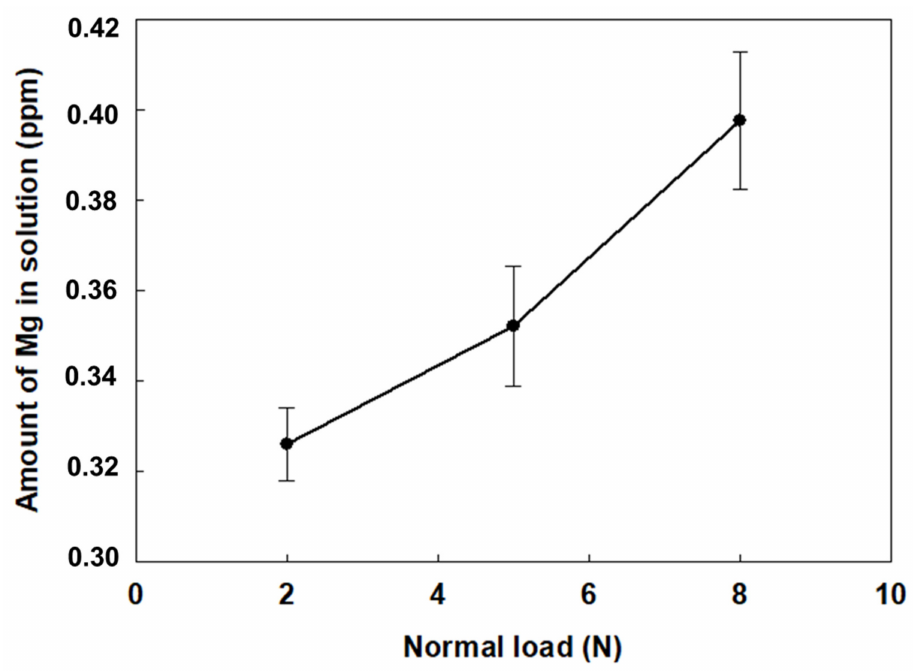
Figure 7. ICP-AES characterization of the solutions after wet sliding wear